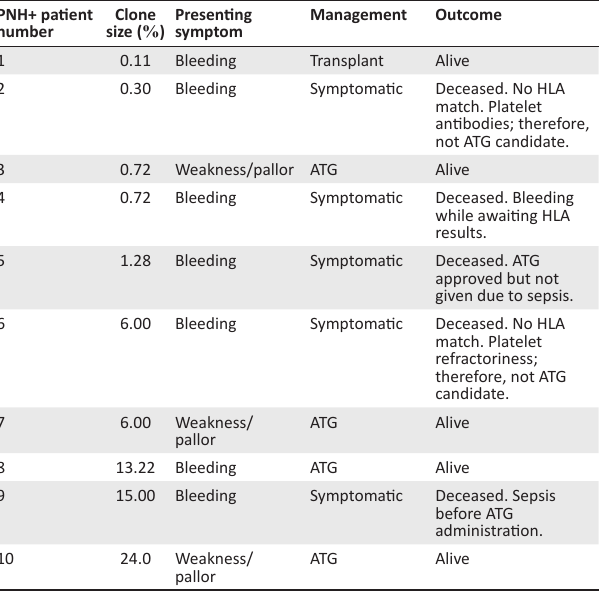
TABLE 2: Paroxysmal nocturnal haemoglobinuria clone sizes and clinical presentation and outcome of patients with aplastic anaemia at the Inkosi Albert Luthuli Central Hospital, Durban, South Africa, September 2013 – January 2018. PNH+ patient Clone Presenting number size ( % ) symptom